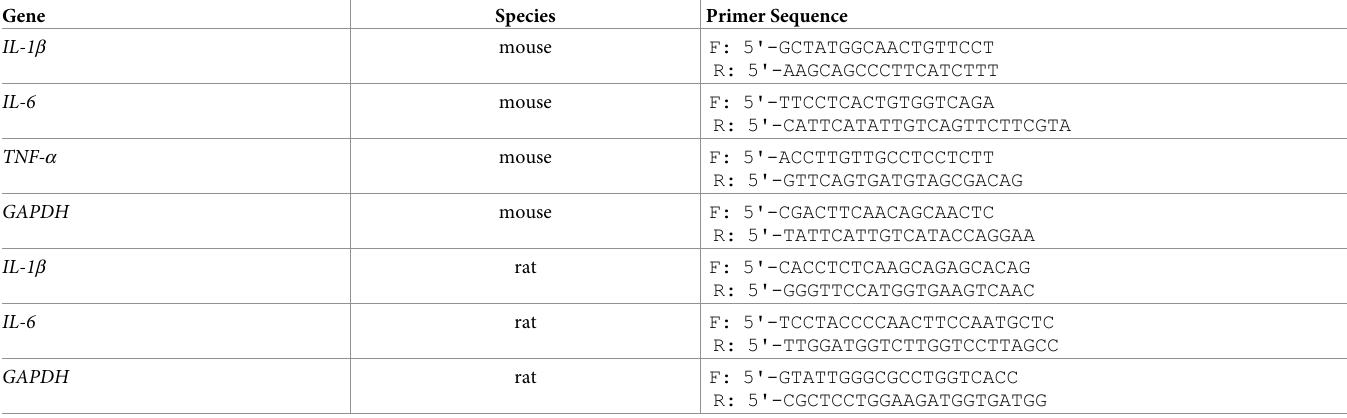
Table 1. The sequences of sense and antisense primers used. Gene Species Primer Sequence IL-1